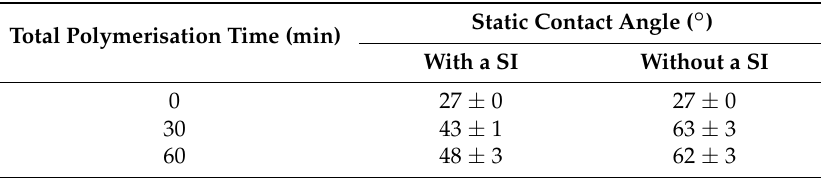
Table 2. Average static CA of a CO 2 plasma-treated 5SBDCSi film before and after performing a SIP for 30 min, and then after a chain-extension for a further 30 min with and without a SI. Static Contact Angle (°) Total Polymerisation Time (min) With a SI Without a SI 0 27 ± 0 27 ± 0 30 43 ± 1 63 ± 3 48 ± 3 62 ± 3